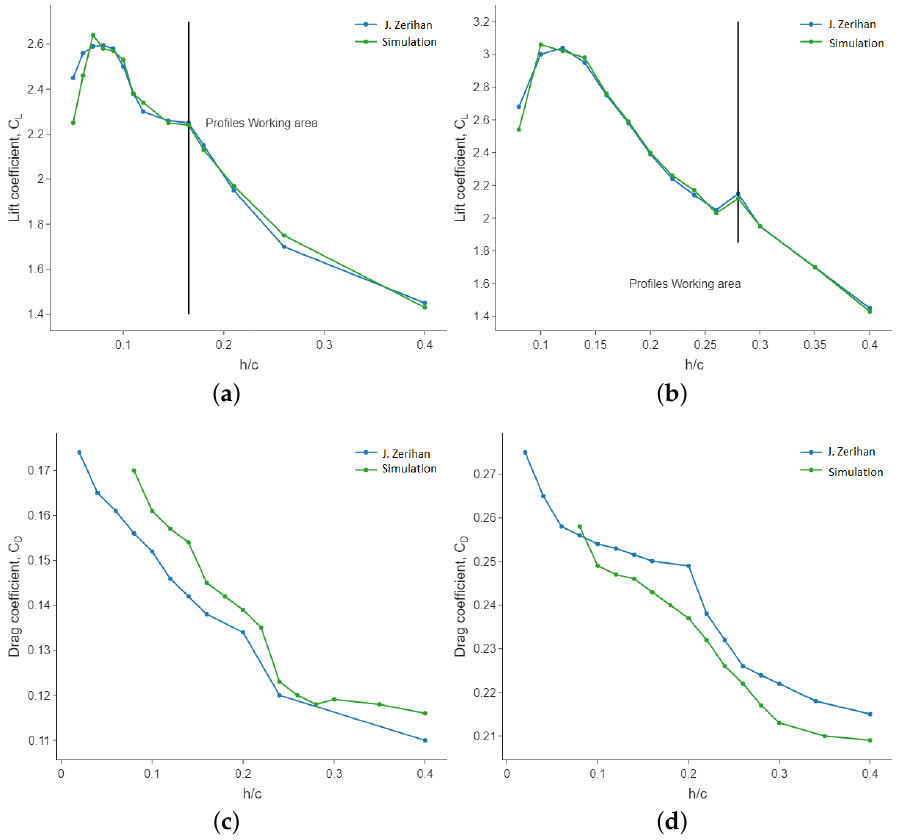
Figure 4. Results of 2-element cascade front wing simulation with ground effect at different heights for downforce with ( a ) Low flap angle, and with ( b ) High flap angle; as well as for drag with ( c ) Low flap angle, and with ( d ) High flap angle. Reference data from J. Zerihan